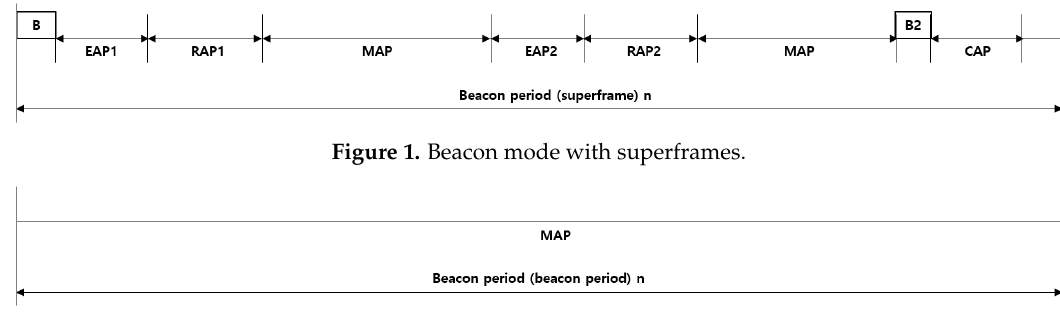
Figure 2. Non-beacon mode with